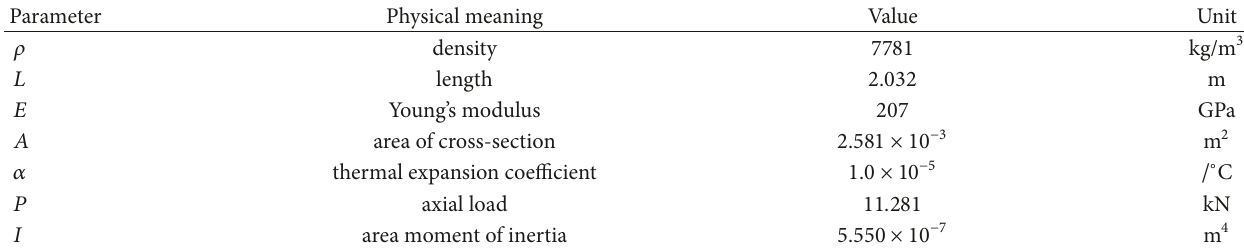
Table 1: Physical parameters and material